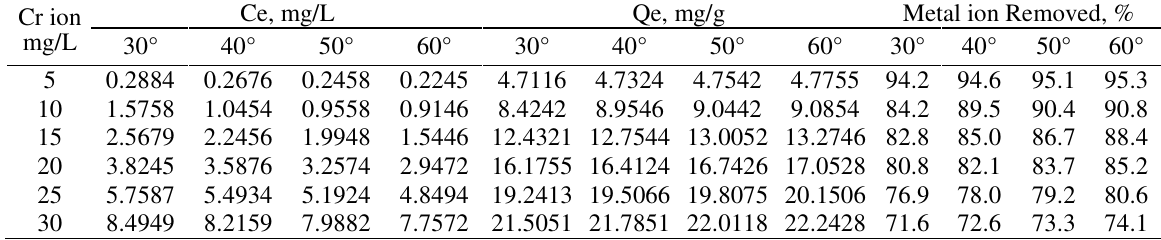
Figure 3. Langmuir adsorption isotherm for the adsorption of chromium ion onto PDC Table 2 . Equilibrium Parameters for the adsorption of chromium ion on to acid activated